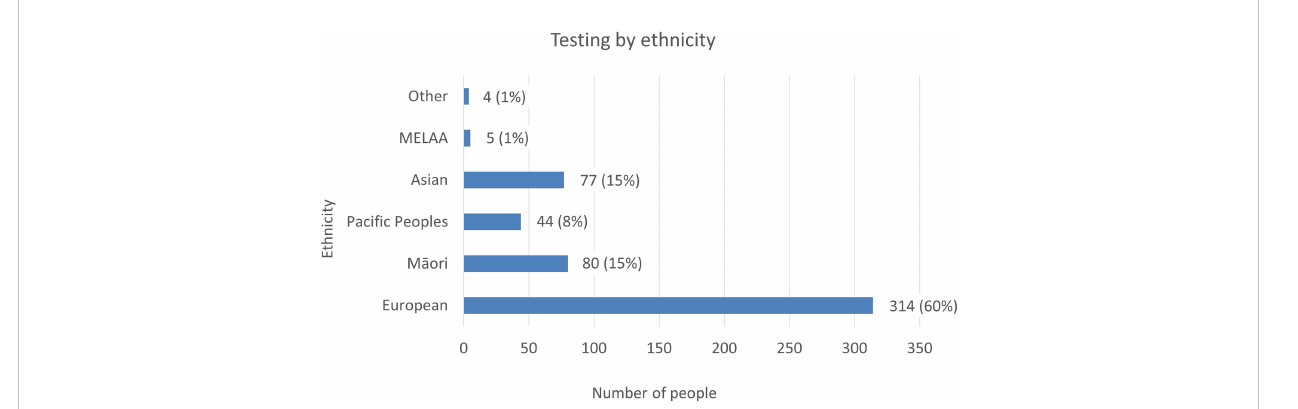
FIGURE 4 The number of tests referred to LabPlus and Exeter, by ethnicity. % Indicates the proportion of testing each ethnicity represents of the total